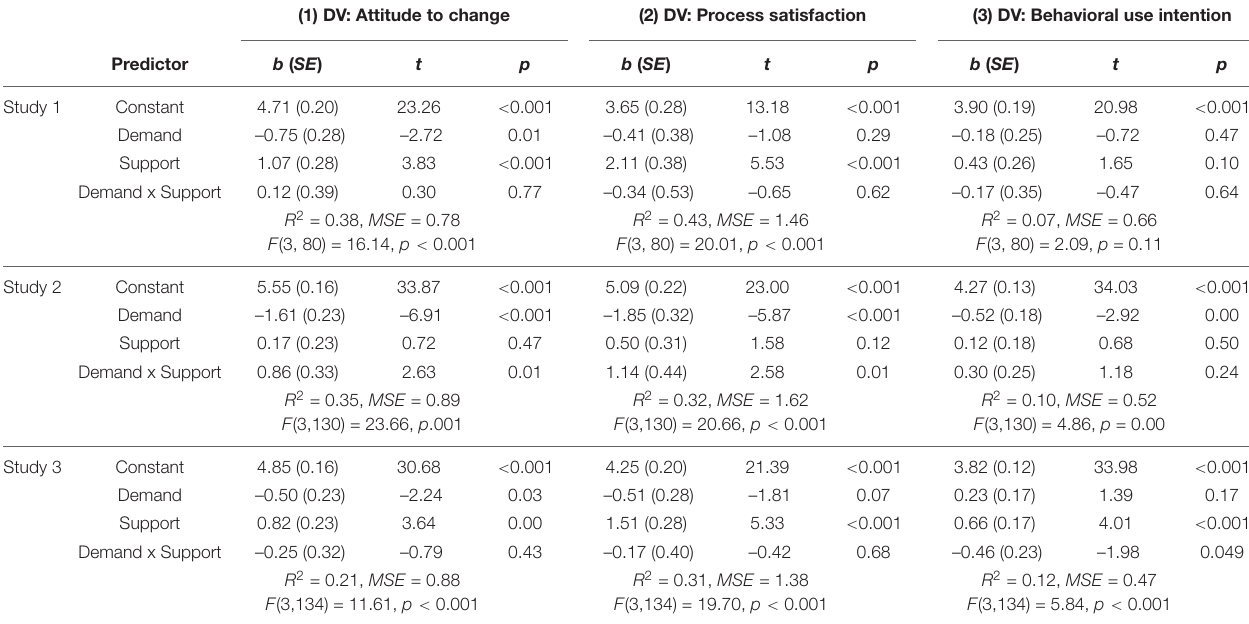
TABLE 3 | Moderation analysis of Studies 1–3. (1) DV: Attitude to change (2) DV: Process satisfaction (3) DV: Behavioral use